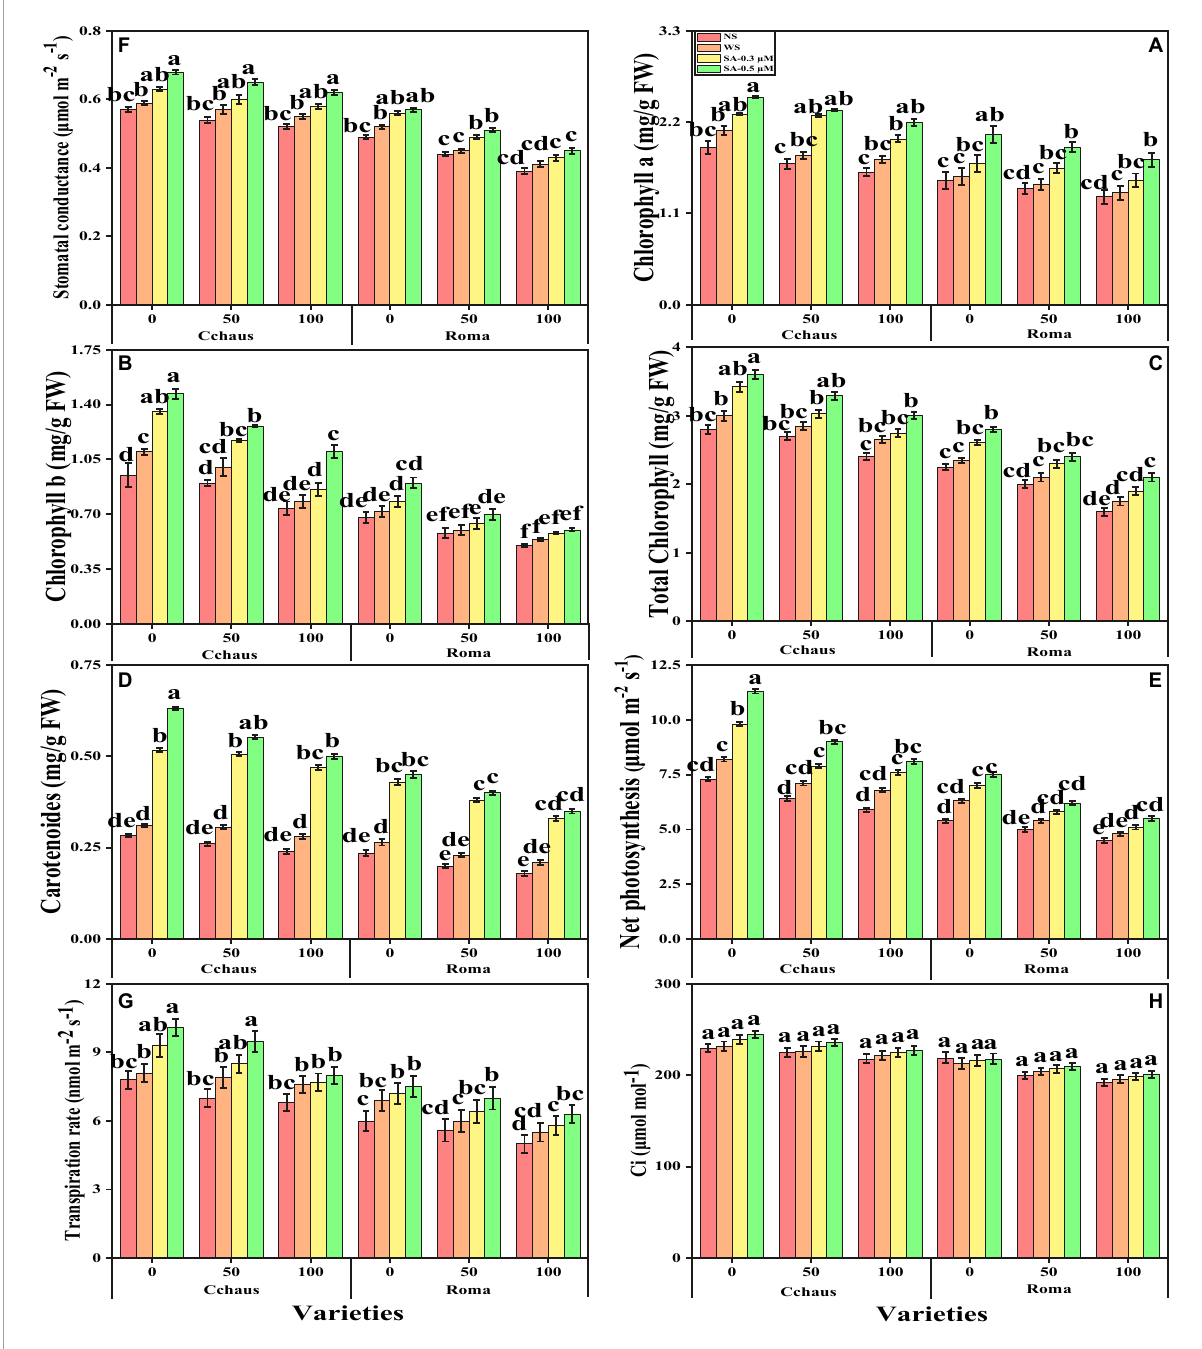
FIGURE2 Effect of exogenously applied syringic acid (0.3-0.5 ◦ µ M) on chlorophyll-a content (A) , chlorophyll-b contents (B) , total chlorophyll contents (C) , carotenoid contents (D) , net photosynthesis, (E) stomatal conductance (F) , transpiration rate (G) , and intercellular CO 2 (H) on Solanum lycopersicum varieties (Cchaus and Roma) cultivated under stress levels of Pb [0 (no Pb), 50 and 100 mg kg − 1 ]. Values are demonstrated as means of four replicates along with standard deviation (SD; n = 4). Two-way ANOVA was performed and means differences were tested by HSD ( P < 0.05) through Tukey’s test. Different lowercase letters on the error bars indicate significant difference between the